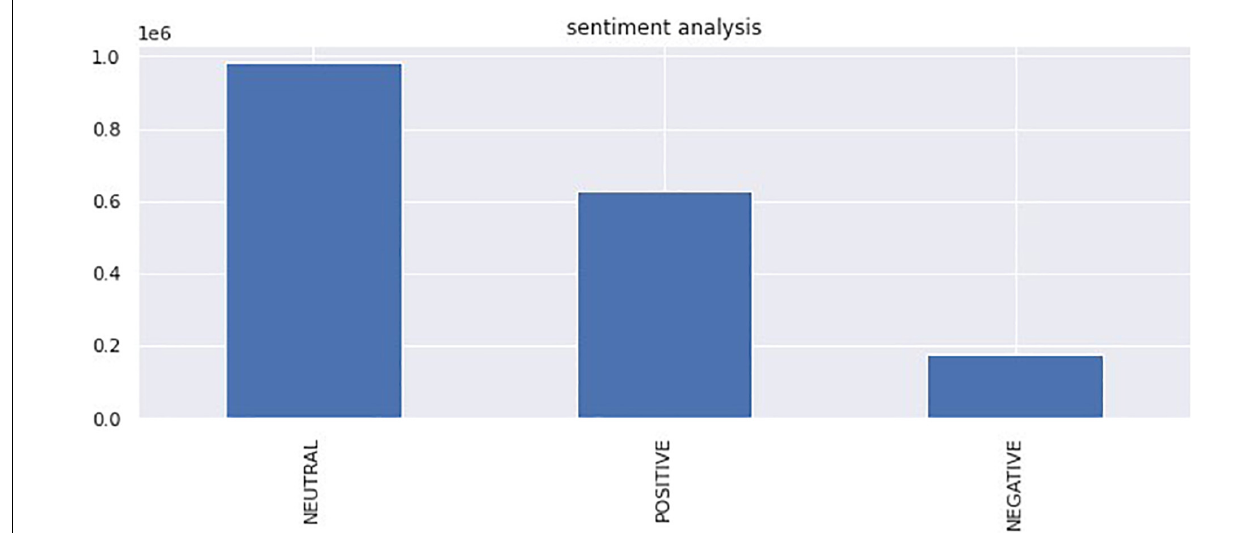
FIGURE 9 | Bar chart of the sentiment score of each tweet.